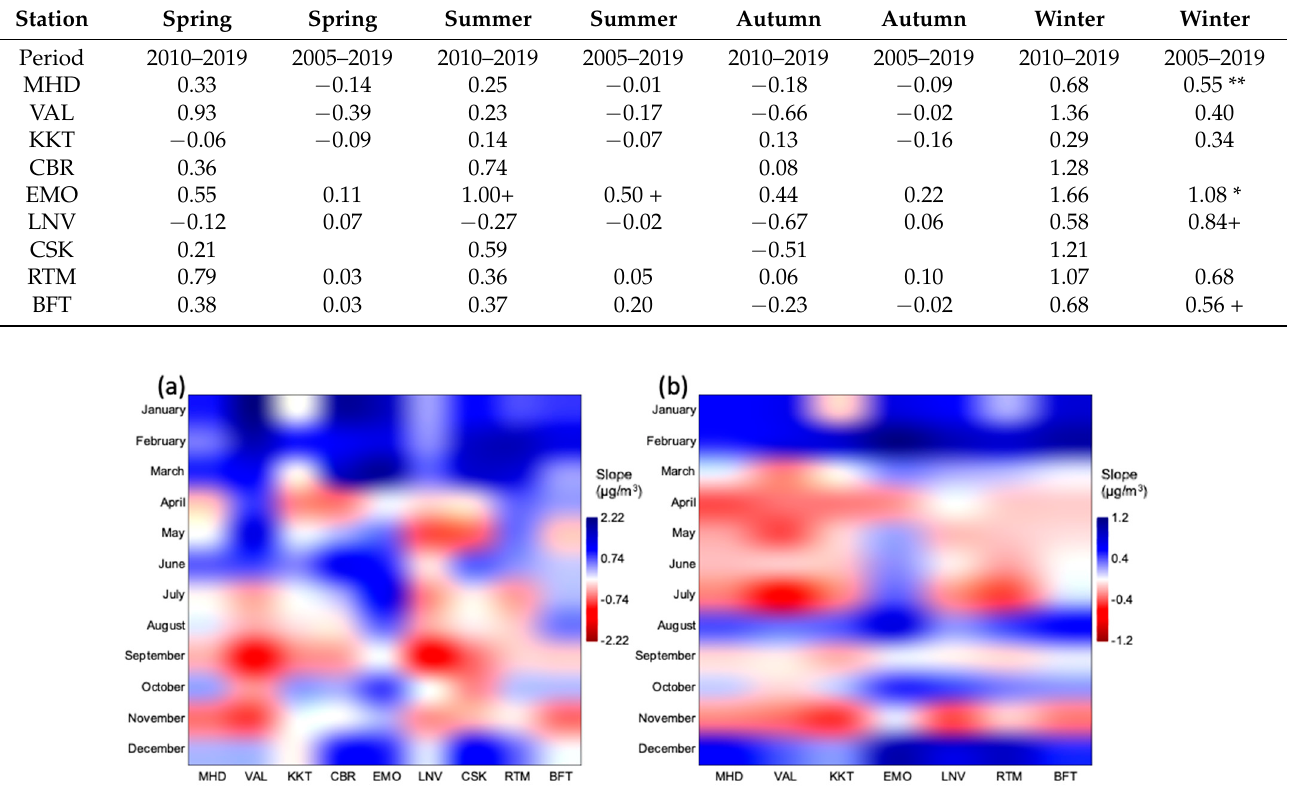
Figure 6. Interpolated matrix plots of trend slope ( µ g/m 3 per year) for long-term monthly ozone concentrations over ( a ) ten years (2010–2019) and ( b ) 15 years (2005–2019); increases in blue and decreases in red (see Tables S6–S9 for data). See Table 1 for station ID codes.